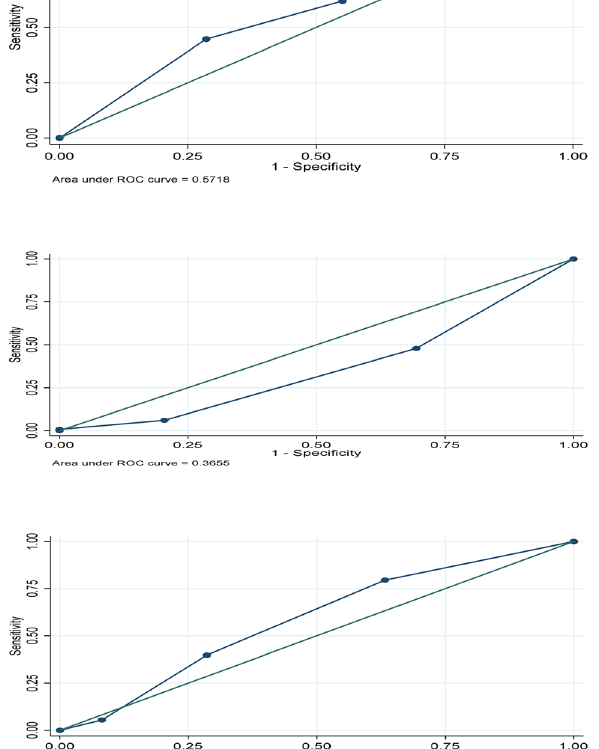
Fig. 11 ROC for RPP. Source: Researchers’ Analysis